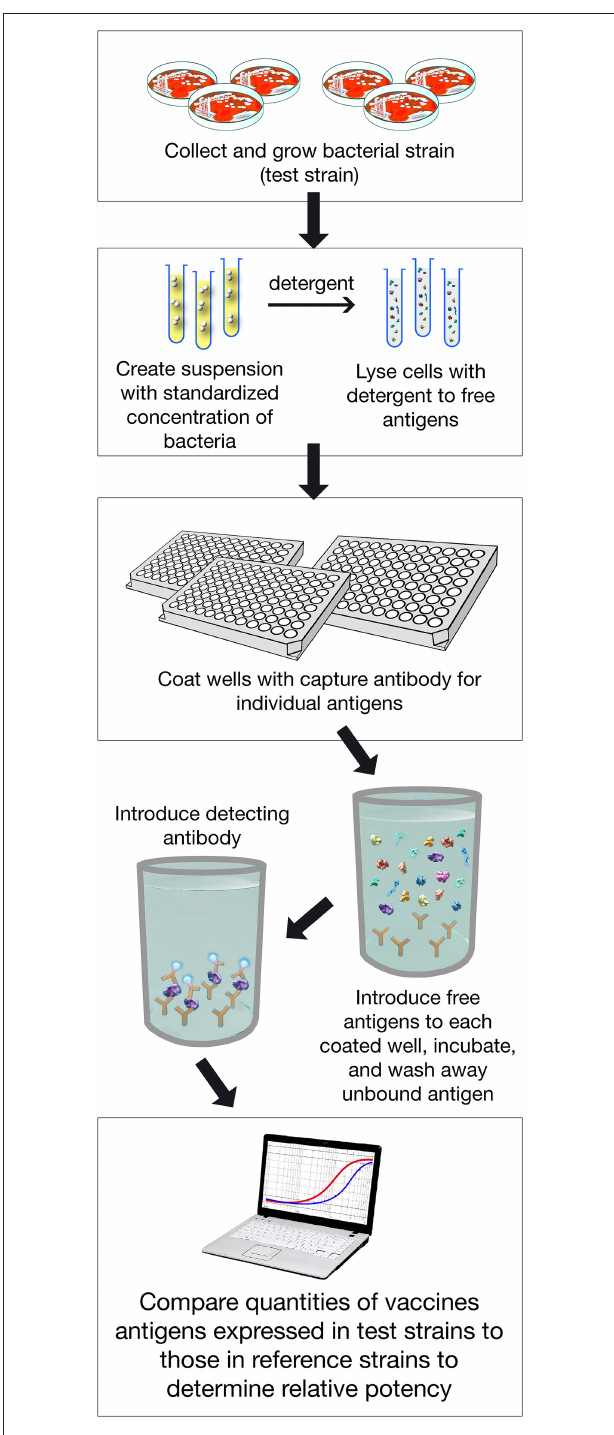
FIGURE 4 | Assay Procedure overview of MATS ELISA. Various steps of the assay are shown. In addition PorA genotype is defined with classical pCR.